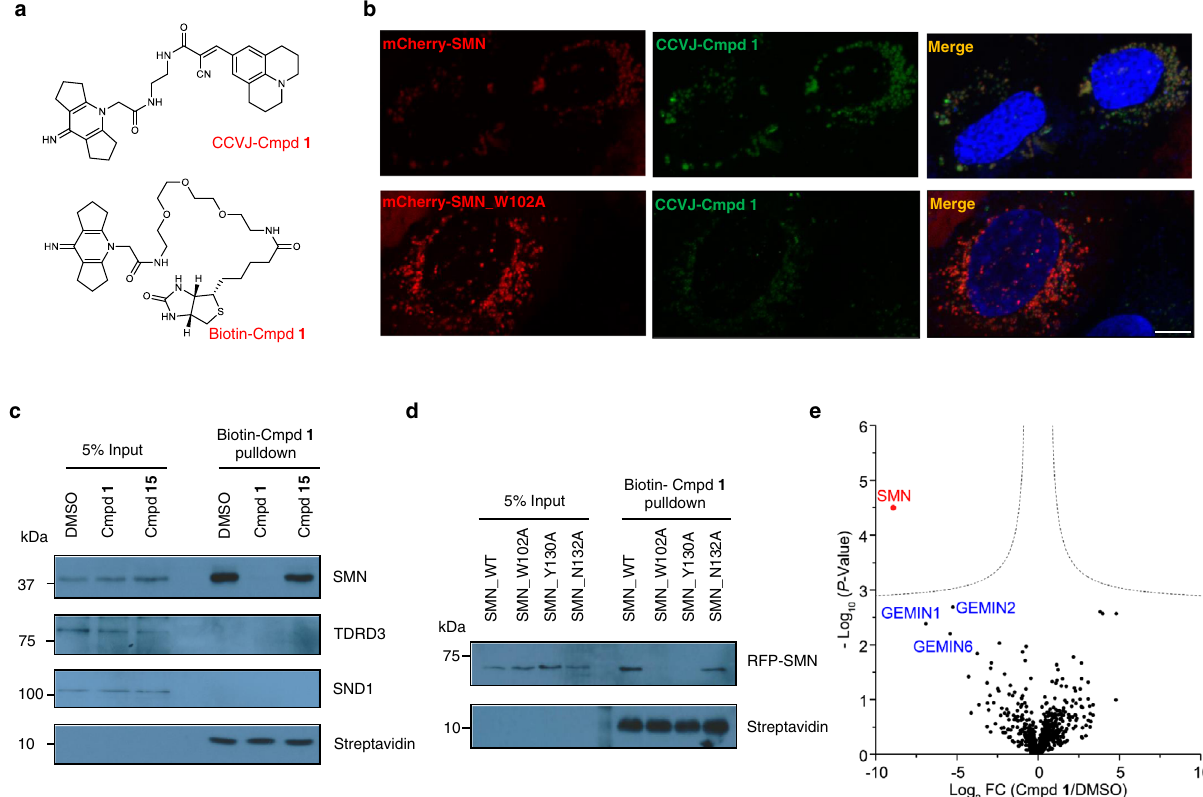
Fig. 2 | Cellular on-target engagement of compound 1 . a Chemical structure of CCVJ conjugated compound 1 (CCVJ-Cmpd 1 ) and biotin conjugated compound 1 (biotin-Cmpd 1 ). b mCherry-SMN (red) colocalizes with CCVJ-Cmpd 1 (green), which is lost when the cage residue W102 is mutated in SMN. Scale bar: 10 μ m. c Compound 1 , but not negative compound 15 , prevents the pulldown of SMN by biotin-labeled compound 1 from cell lysates. d SMN cage mutants disrupt or weaken the interaction between SMN and biotin-Cmpd 1 in cell lysates. The U2OS cell lysate was incubated with 20 μ M of biotin-Cmpd 1 overnight at 4°C in fi gures